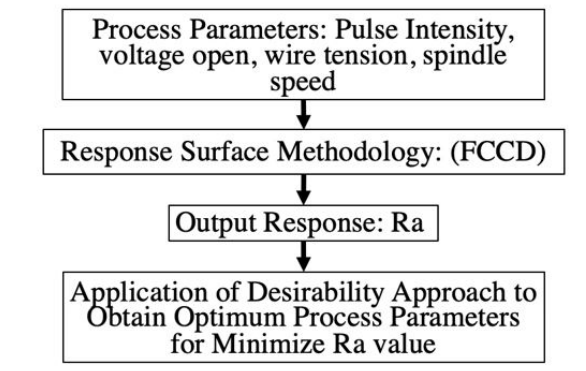
Fig. 3. Flow chart design of experiment used in this